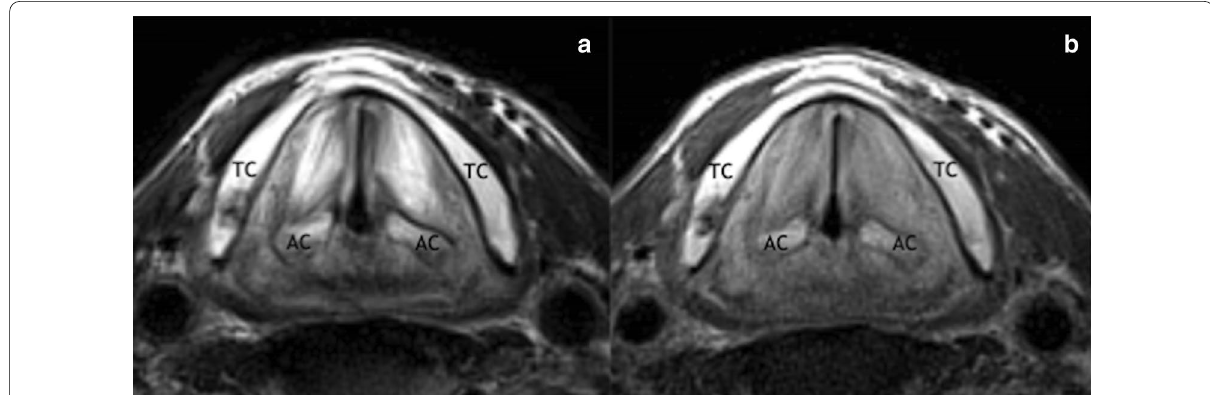
Fig. 6 Chronic edema of the true vocal folds 14 years after ChT/RT in a 72-year-old man with lymph node metastasis from unknown primary. Axial T2-weighted ( a ) and T1-weighted ( b ) images acquired with surface-coil MRI of the larynx show diffuse T2-hyperintensity and slightly